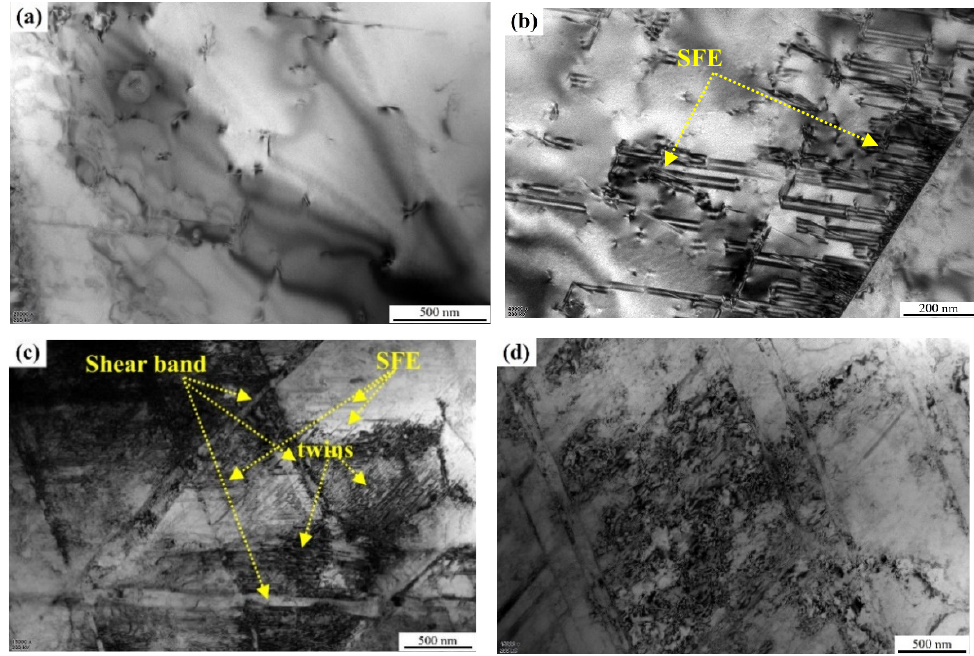
Figure 3. TEM images of AISI 304 SS before and after expansion: ( a , b ) before expansion; ( c , d ) after expansion.